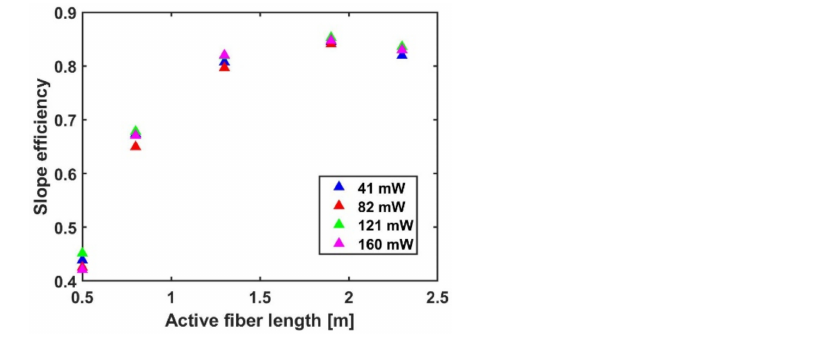
Figure 5. The slope efficiency of output emission around 980 nm via active fiber length.